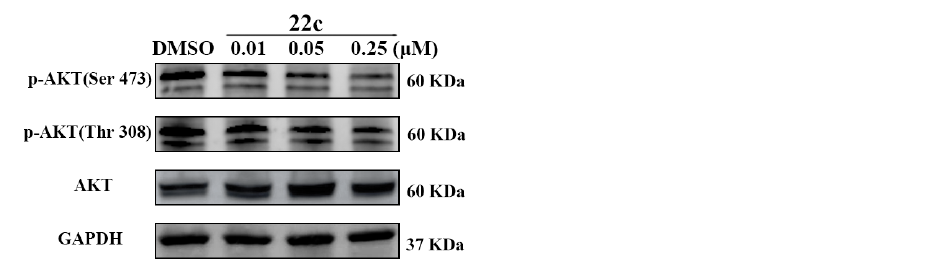
Figure 3. Compound 22c inhibited phosphorylation of PI3K downstream effectors AKT in HCT-116 cells.